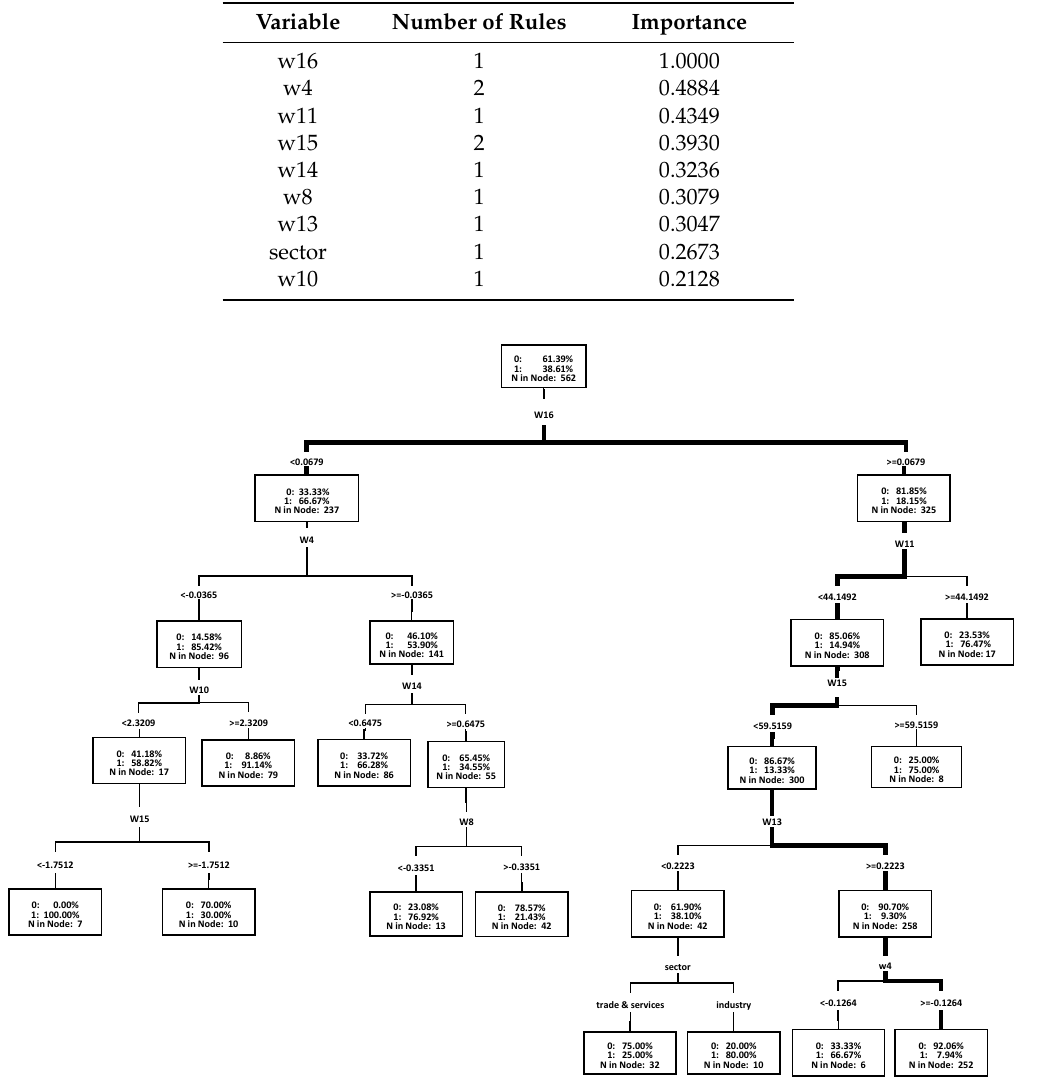
Table 3. Importance of variables in the decision tree.